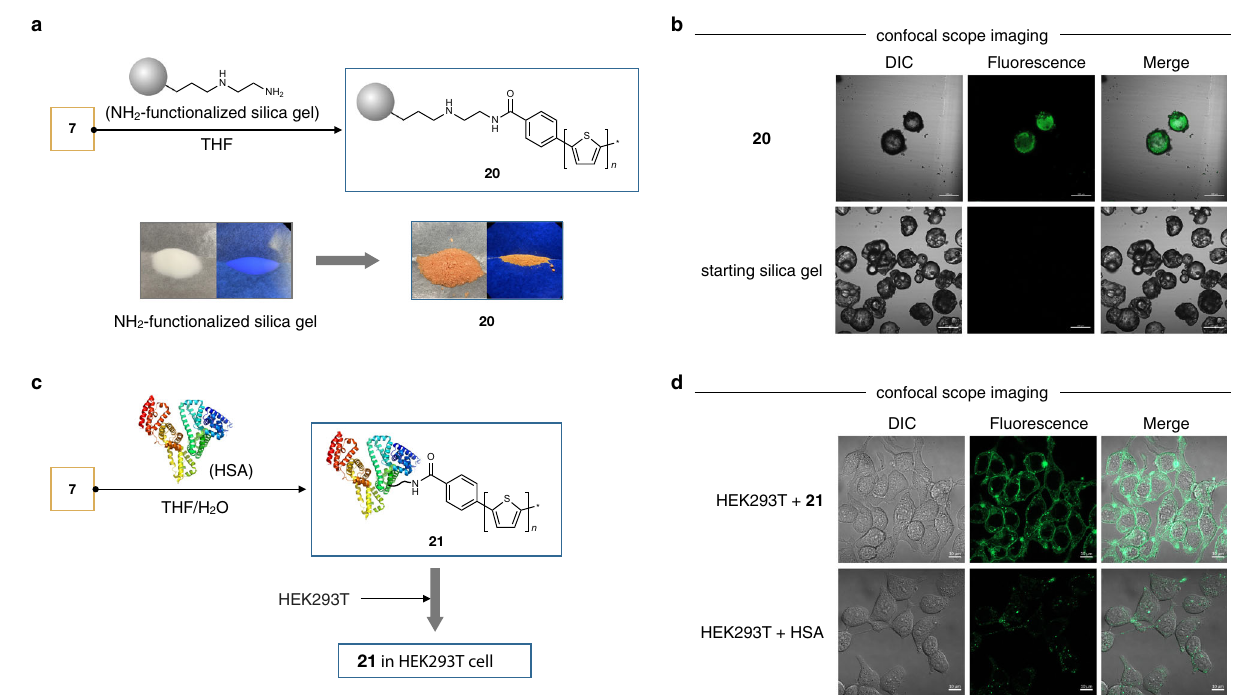
Fig. 6 | Transfer of bare aromatic polymers to other functional materials. a Synthesis of polythiophene-attached silica gel 20 . Starting white NH 2 -functiona- lized silica gel shows no fl uorescence. Red-colored 20 shows orange fl uorescence under 365nm UV irradiation. b Confocal scope images of 20 (top) and starting